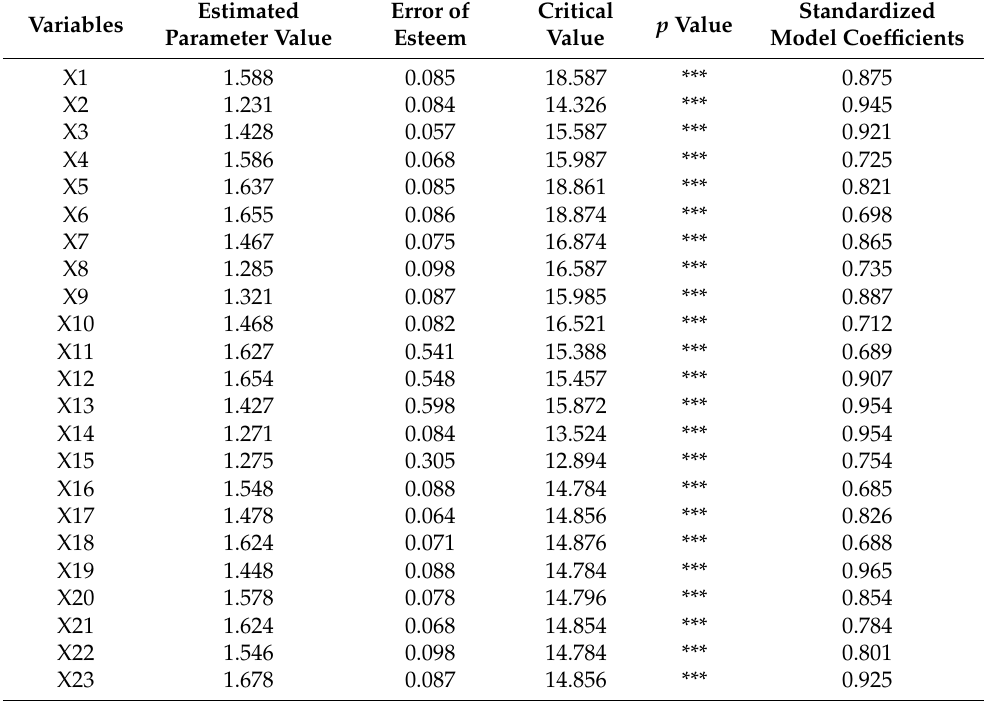
Table 5. Unstandardized and standardized model coefficients. Estimated Variables Parameter